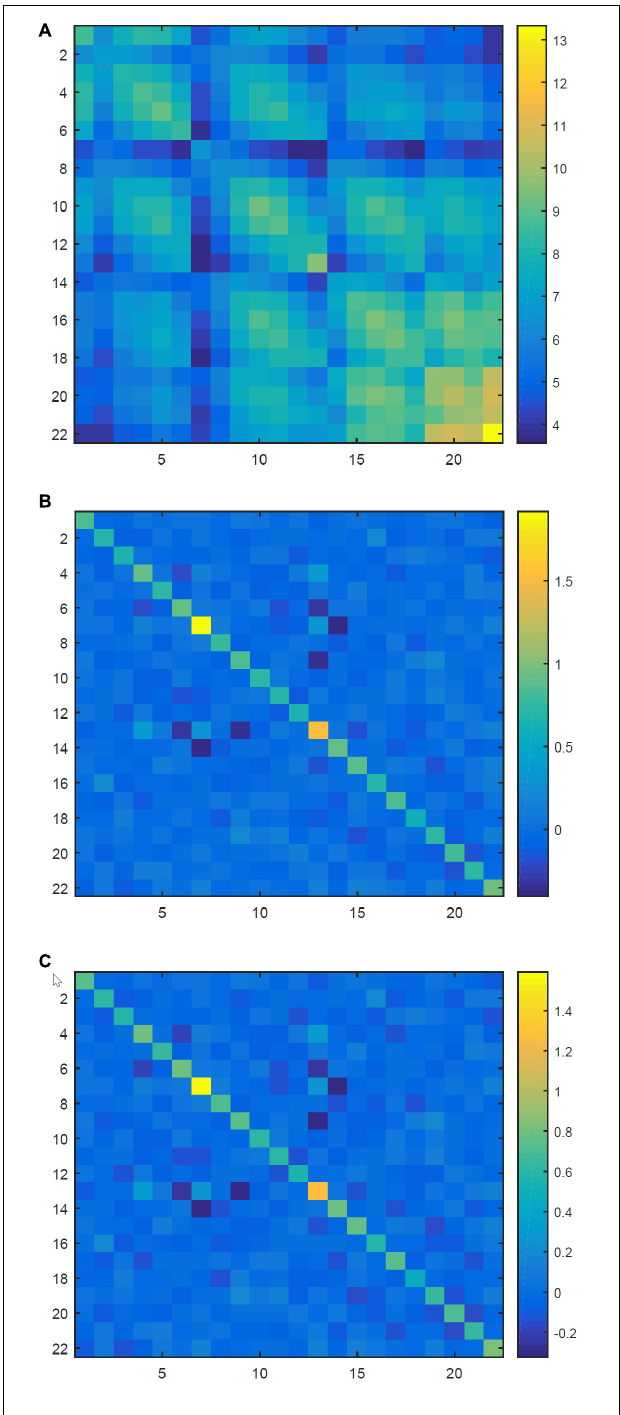
FIGURE 3 | The raw covariance matrix and different aligned matrices. (A) The raw covariance matrix. (B) The aligned covariance matrix after RA. (C) The aligned covariance matrix after